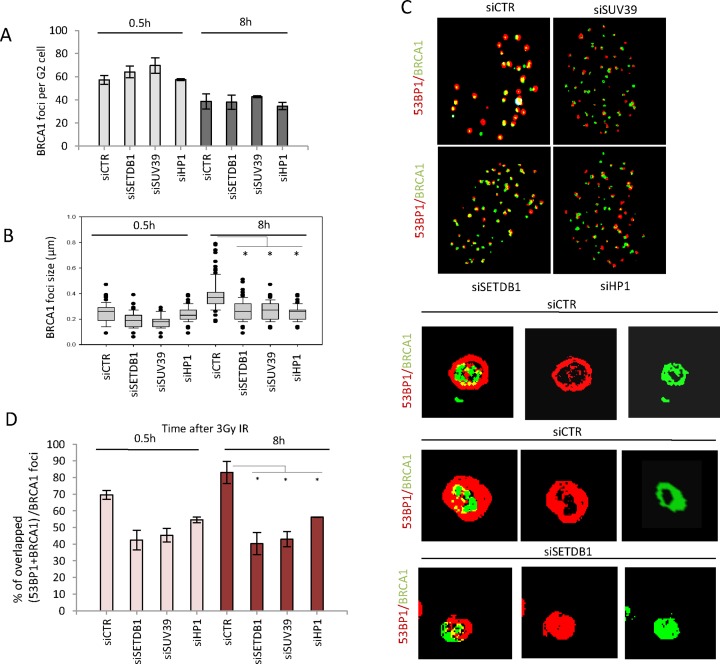
SETDB1, SUV39 and HP1 are dispensable for BRCA1 recruitment but required for its enlargement and localization within IRIF. (A) BRCA1 foci were enumerated in 1BR3 hTERT cells at 0.5 and 8 h in G2 cells post 3 Gy IR following the indicated siRNA-mediated knockdown. Note that Delta Vision microscopy was used for this analysis in contrast to Figure 1. The number of foci (γH2AX and BRCA1) is elevated when enumerated using Delta Vision microscopy due to the better delivery of the light source to the objective lens and enhanced contrast. Thus, foci numbers here do not correlate with those in Figure 1 although the relative impact of siRNA remains consistent. (B) BRCA1 foci size was analysed in G2 cells after 3 Gy IR at the indicated time points using softWoRx® suite software. Data are the mean ± S.E.M of three experiments. Asterisks denote statistically significant differences (P < 0.05; t-test). (C) 1BR3 hTERT cells were transfected with siRNAs targeting control (CTR) or SETDB1, SUV39, HP1, 48 h later cells were irradiated with 3 Gy and co-stained with BRCA1 and 53BP1 antibody at 8 h post IR. Images were taken by Delta Vision microscopy. In the bottom panel, representative 3D images were generated by the softWoRx® suite software. Panels shows representative images of 53BP1 and/or BRCA1 at 8 h post IR. Top two lines of the bottom panel show two images after siCTR and the bottom row after siRNA SETDB1 (siSETDB1). Images highlight lack of overlap of 53BP1 and BRCA1 foci after knockdown of SETDB1 and the lack of a devoid core. Knockdown of the other compacting factors gave images similar to those after siRNA SETDB1. Note that the top images show a 2D representation and not all foci are therefore observed. (D) The overlap of BRCA1 and 53BP1 foci was quantified in deconvolved Delta Vision 2D images by the softWoRx® suite software. The result indicates percentage of overlapping foci between (BRCA1+ 53BP1) relative to total BRCA1 foci. The Pearson coefficient of correlation monitors how closely two intensities overlap on a pixel-by-pixel basis (full overlapping is 1.0). Asterisks indicate statistical difference (P < 0.05; t-test).